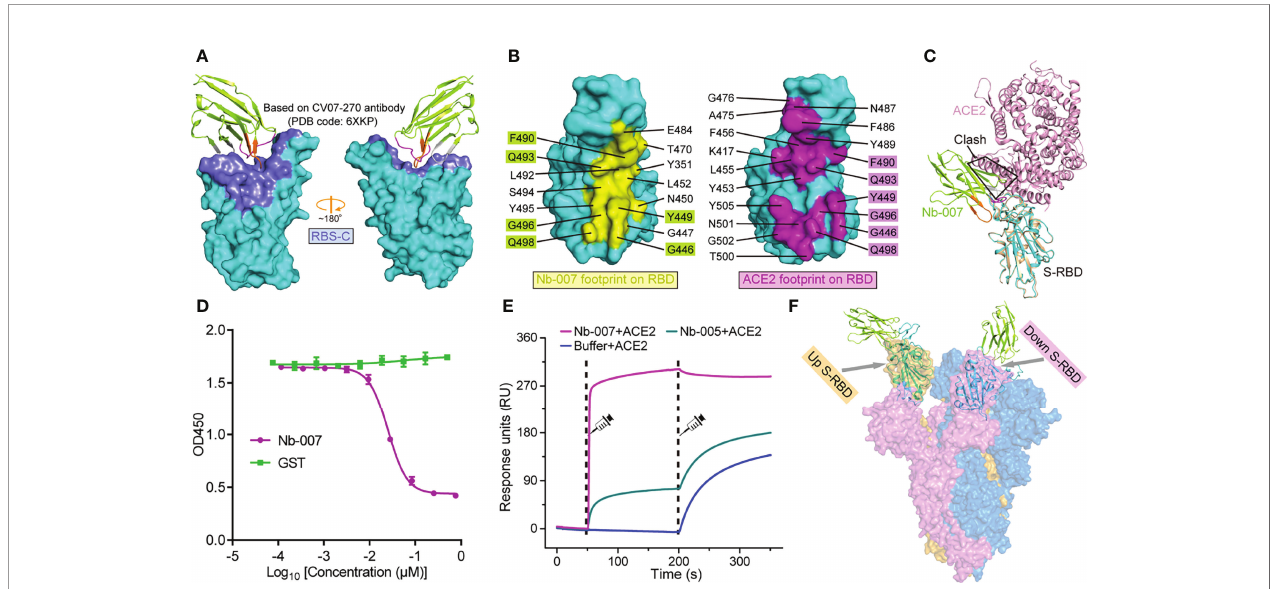
FIGURE 4 | Molecular basis for Nb-007 neutralization. (A) The previously identi fi ed RBS-C epitope [Based on CV07-270 antibody (PDB code: 6XKP)] is colored by slate and mapped onto our Nb-007/S-RBD complex. The relative orientation of RBD is the same as in Supplementary Figure 7 . Nb-007 is shown in cartoon representation and colored as in Figure 3 . (B) The footprints of Nb-007 (left panel, highlighted in yellow) and ACE2 (right panel, highlighted in magenta) on S-RBD. The involved residues are marked and the overlapping amino acids are highlighted. (C) Superimposition of the complex structures of Nb-007/S-RBD and ACE2/S- RBD. Steric clashes between Nb-007 and ACE2 are highlighted. (D) Competitive binding assays by ELISA. SARS-CoV-2 S-RBD was coated on 96-well plates, recombinant Fc-fused ACE2 was fi rst added, followed by serial dilutions of Nb-007. Error bar stands for the mean ± SD. Experiments were performed in triplicate. (E) SPR kinetics of competitive binding of Nb-007 and ACE2 to SARS-CoV-2 S-RBD. S-RBD was immobilized onto a sensor chip. The indicated nanobodies (Nb- 007 and Nb-005) and ACE2 were successively injected. The real-time binding pro fi les are recorded. Clearly shown is that Nb-007 but not Nb-005 interferes with ACE2 binding. (F) Alignment of the Nb-007/S-RBD structure (shown in cartoon) onto a previously solved cryo-EM structure of the SARS-CoV-2 S-trimer (shown in surface, PDB code: 6VYB). The up- and down-conformation of the S-RBD are